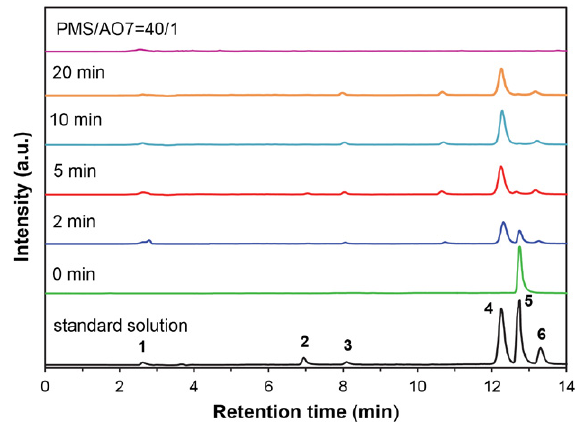
Fig. 10. HPLC chromatograms of AO7 during catalytic oxidation on 50% Bi 2 O 3 -Co 3 O 4 and standard solution [(1) 4-hydroxyben- zenesulfonic acid, (2) phthalic anhydride, (3) phthalimide, (4) 1,2-naphthoquinone, (5) AO7, (6) coumarin]. Reaction conditions: [AO7] o = 50 mg/L; [PMS]/[AO7] = 6; [Catalyst] = 0.1 g/L; initial pH = 3.04; T = 293